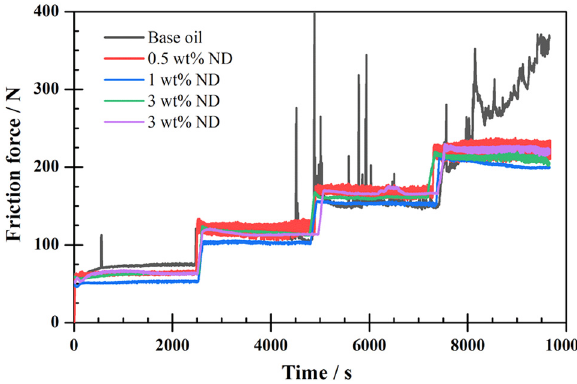
Figure 2: Variation of the friction force between Cr liner and CrN piston ring.